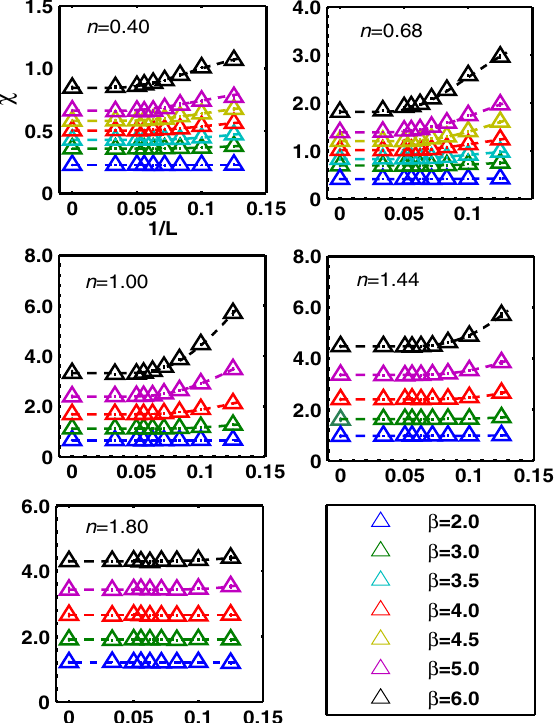
FIG. 11. The finite-size scalings for χ ð T; L Þ versus 1 =L with the fitting χ ð T; L Þ ¼ aLe − L=b þ χ ð T Þ . Values of β ¼ 1 =T are presented in the legend. The parameter value at V ¼ 0 and J ¼ 2 .